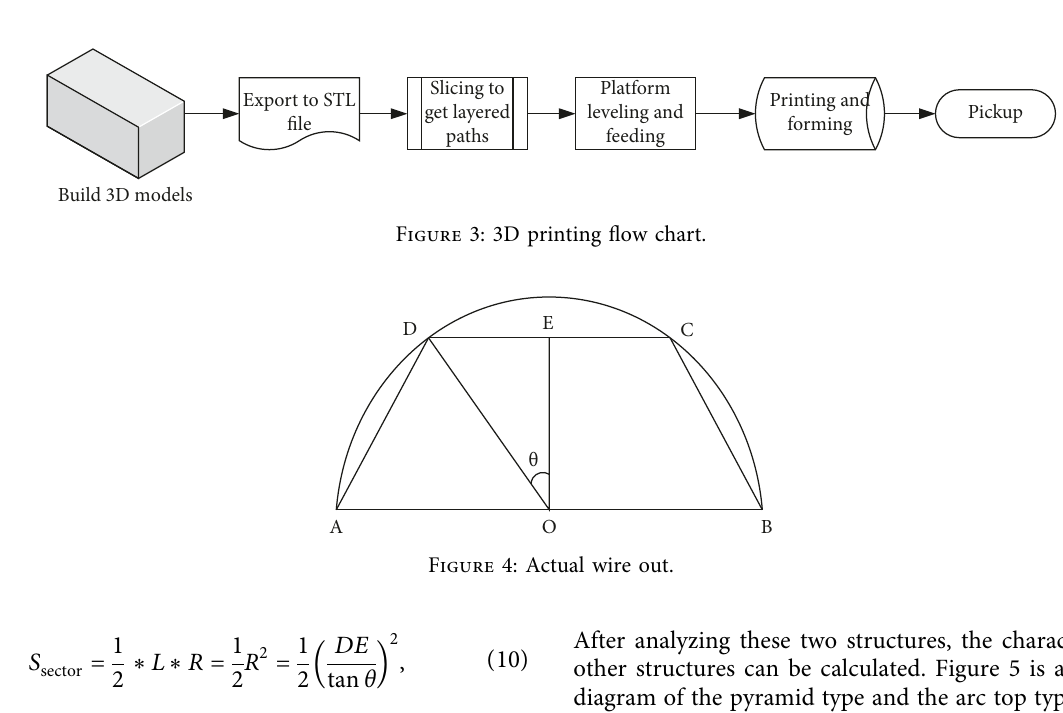
Figure 2: Classification of 3D printing technologies by principle.